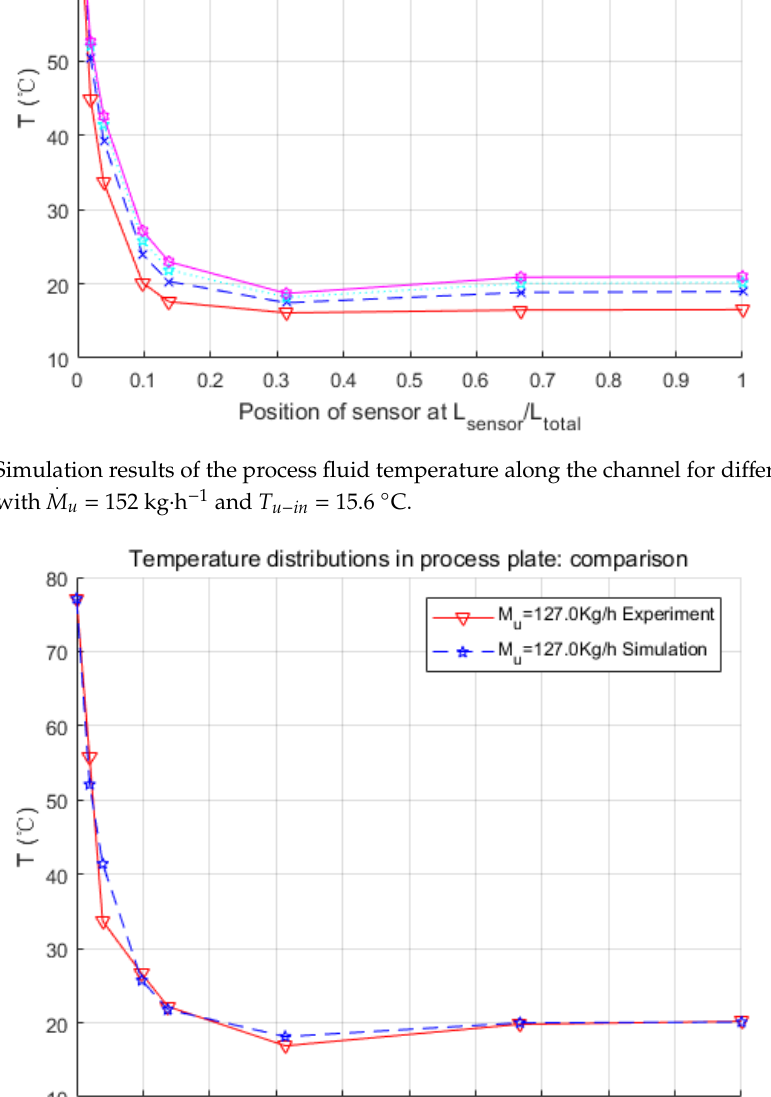
Processes 2019 , 7 , 454 14 of 19